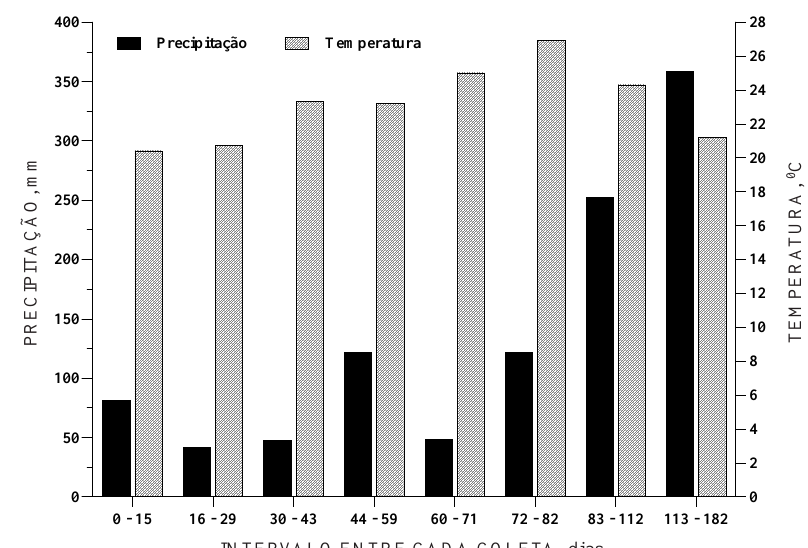
Figura 1. Precipitação pluvial e temperatura média do ar em cada intervalo de coleta dos sacos de decomposição durante o período em que permaneceram no